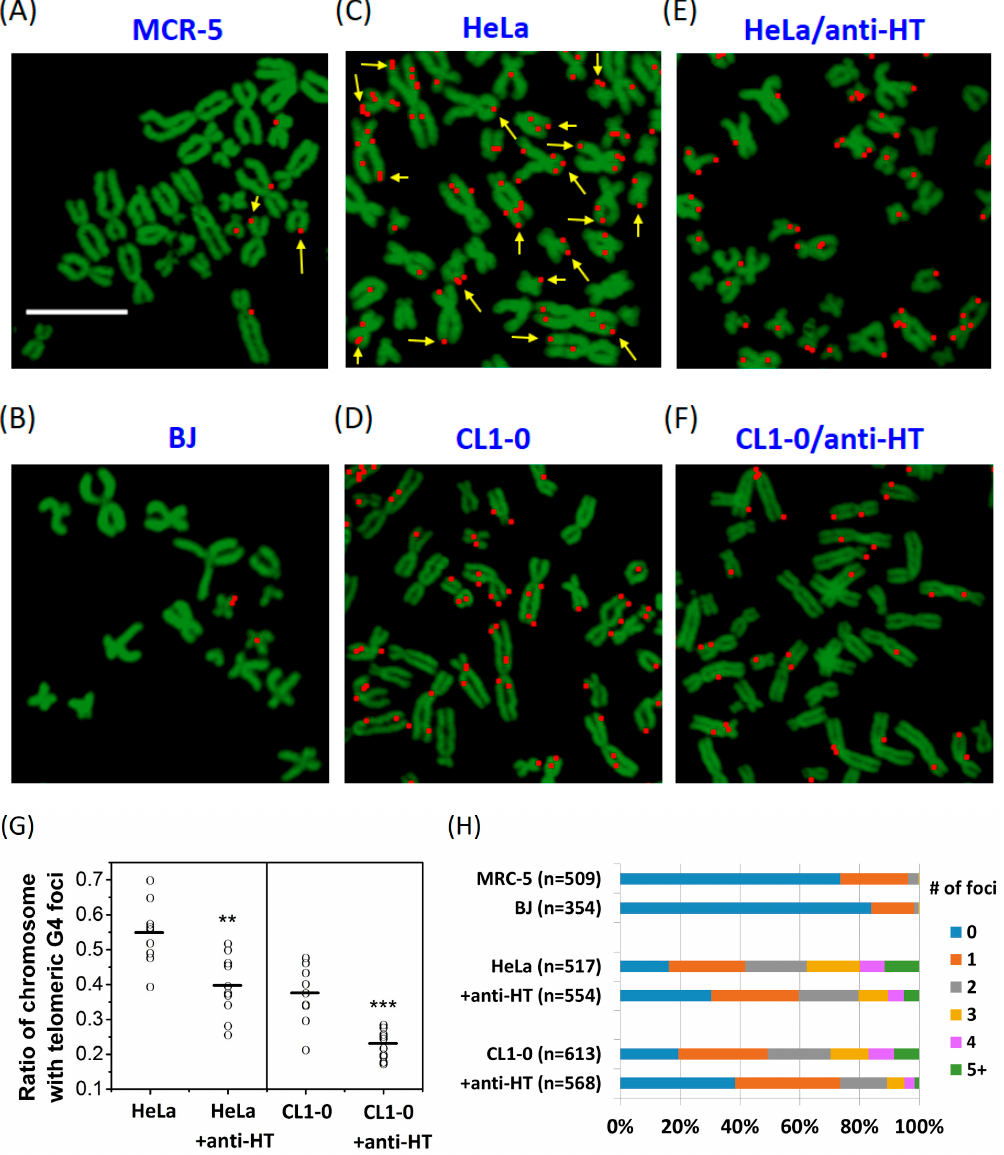
Figure 3. Time-gated FLIM imaging of o -BMVC foci on metaphase chromosomes isolated from MCR-5 ( A ) and BJ ( B ) normal cells, as well as HeLa ( C ) and CL1-0 ( D ) cancer cells, together with the anti-HT pretreated HeLa ( E ) and CL1-0 ( F ) cancer cells. Scale bar, 10 µ m. The arrow symbolizes an o -BMVC focus located one end of the chromosome. The images were presented in pseudo-color and were separated into two components, with color in red (decay time ≥ 2.4 ns) and in green (decay time < 2.4 ns). The scale bar marked in Figurer A is also valid for Figure B–F. ( G ) The scatter plots of the ratio, detecting at least one o -BMVC focus at the ends of chromosomes extracted from HeLa and CL1-0 cancer cells after the addition of anti-HT sequences to the total chromosomes in each image. ( p value: ** p < 0.01; *** p < 0.001) ( H ) The chart represents quantitative analysis of the number of o -BMVC foci per chromosome extracted from di ff erent cell